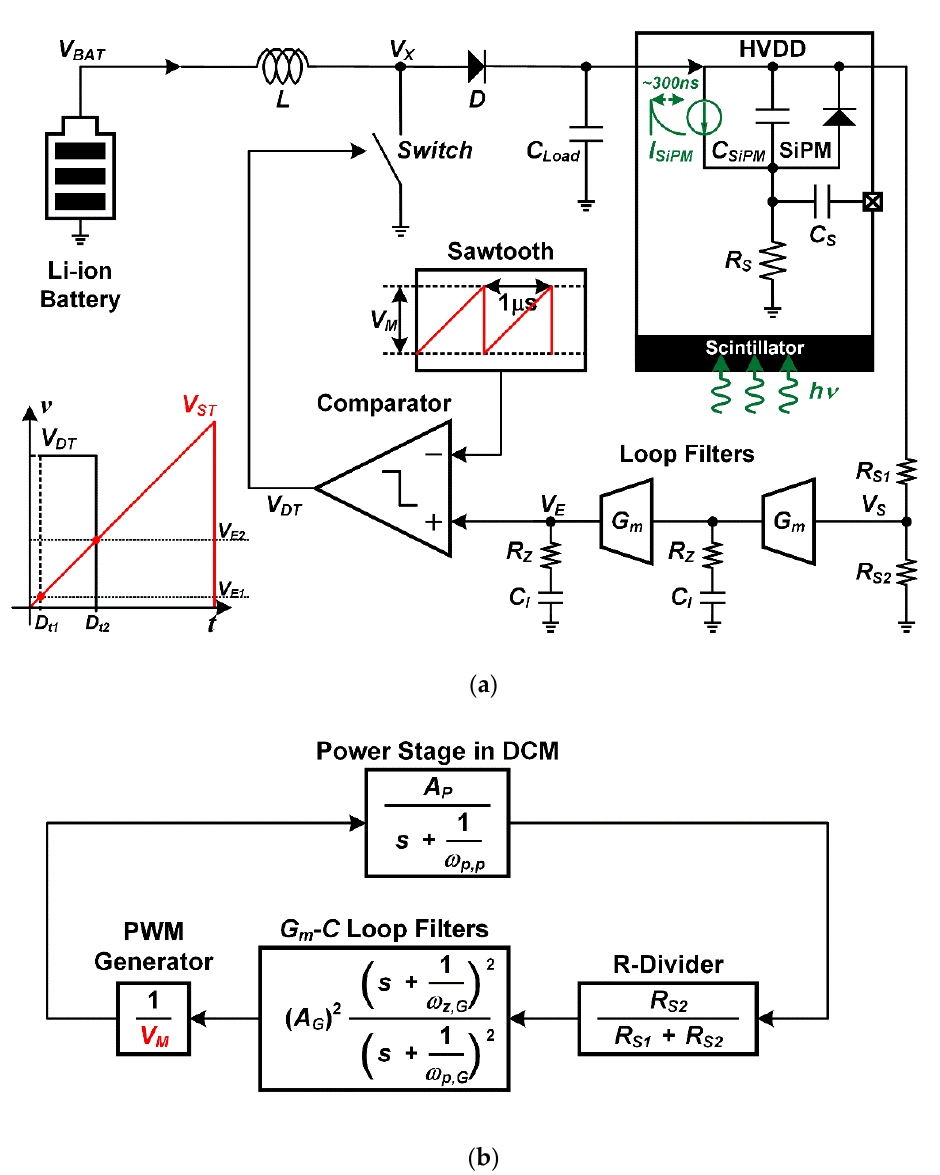
Figure 4. Basic operation of voltage-mode boost converter: ( a ) block diagram, ( b ) small-signal model.